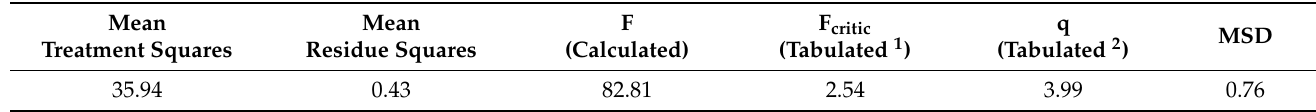
Table 7. ANOVA and Tukey’s test statistical parameters for composite toughness.